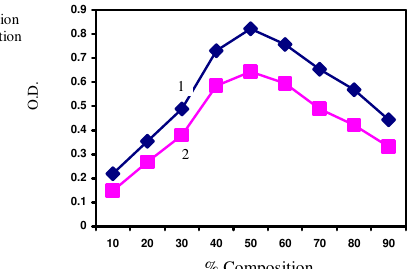
Figure 4 . Plots of O.D. vs. % composition of metal ions -Yb(III)